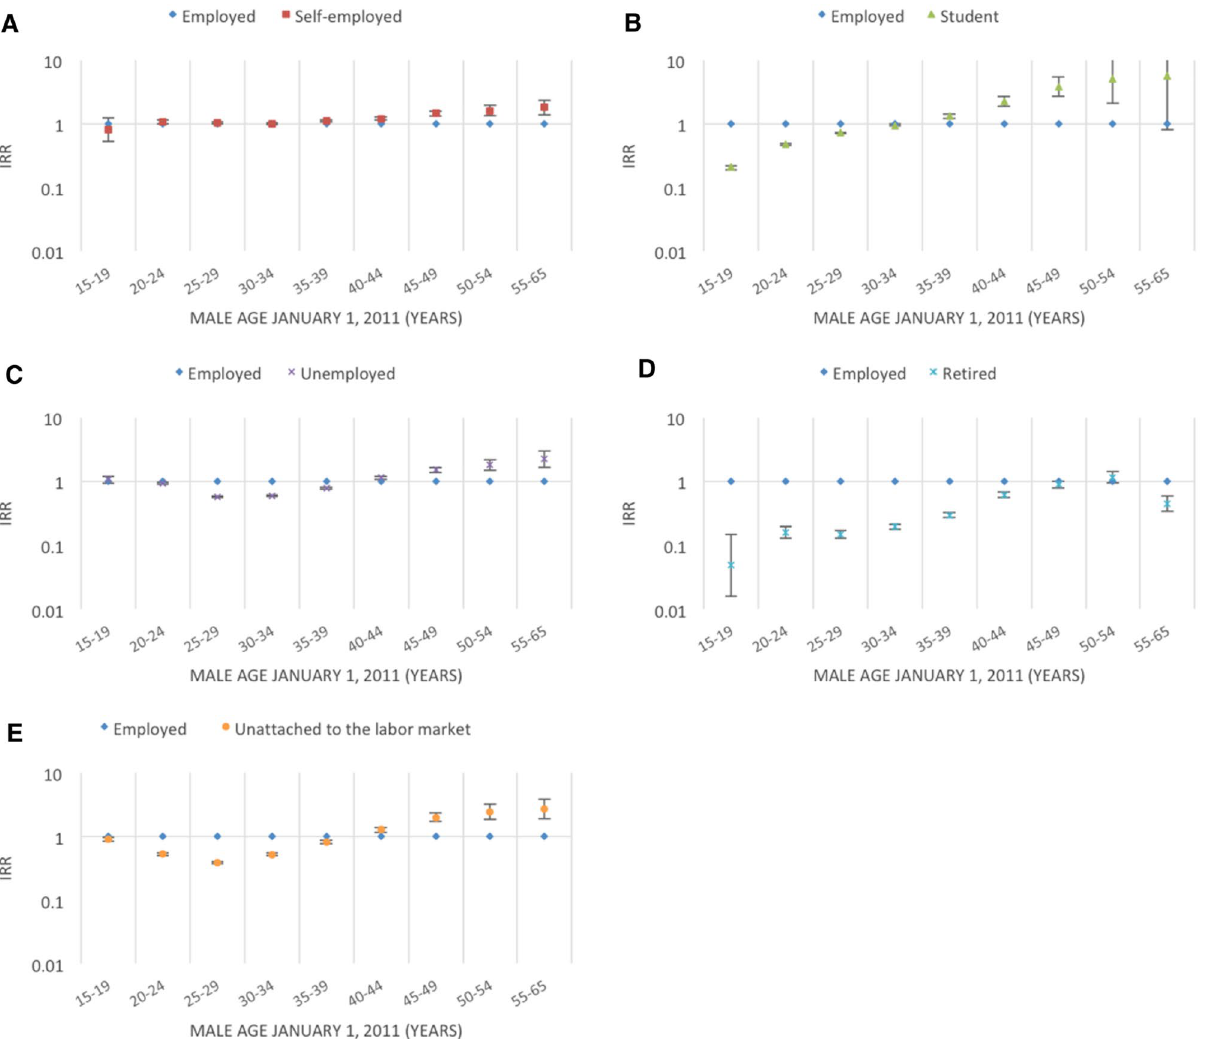
Figure 5. Incidence rate ratios (IRR) of fathering a child according to employment status 1 and age 2 . Men